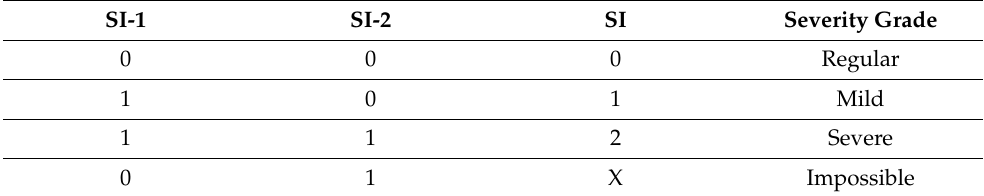
Table 1. SI-1 and SI-2 combinations for severity estimation.